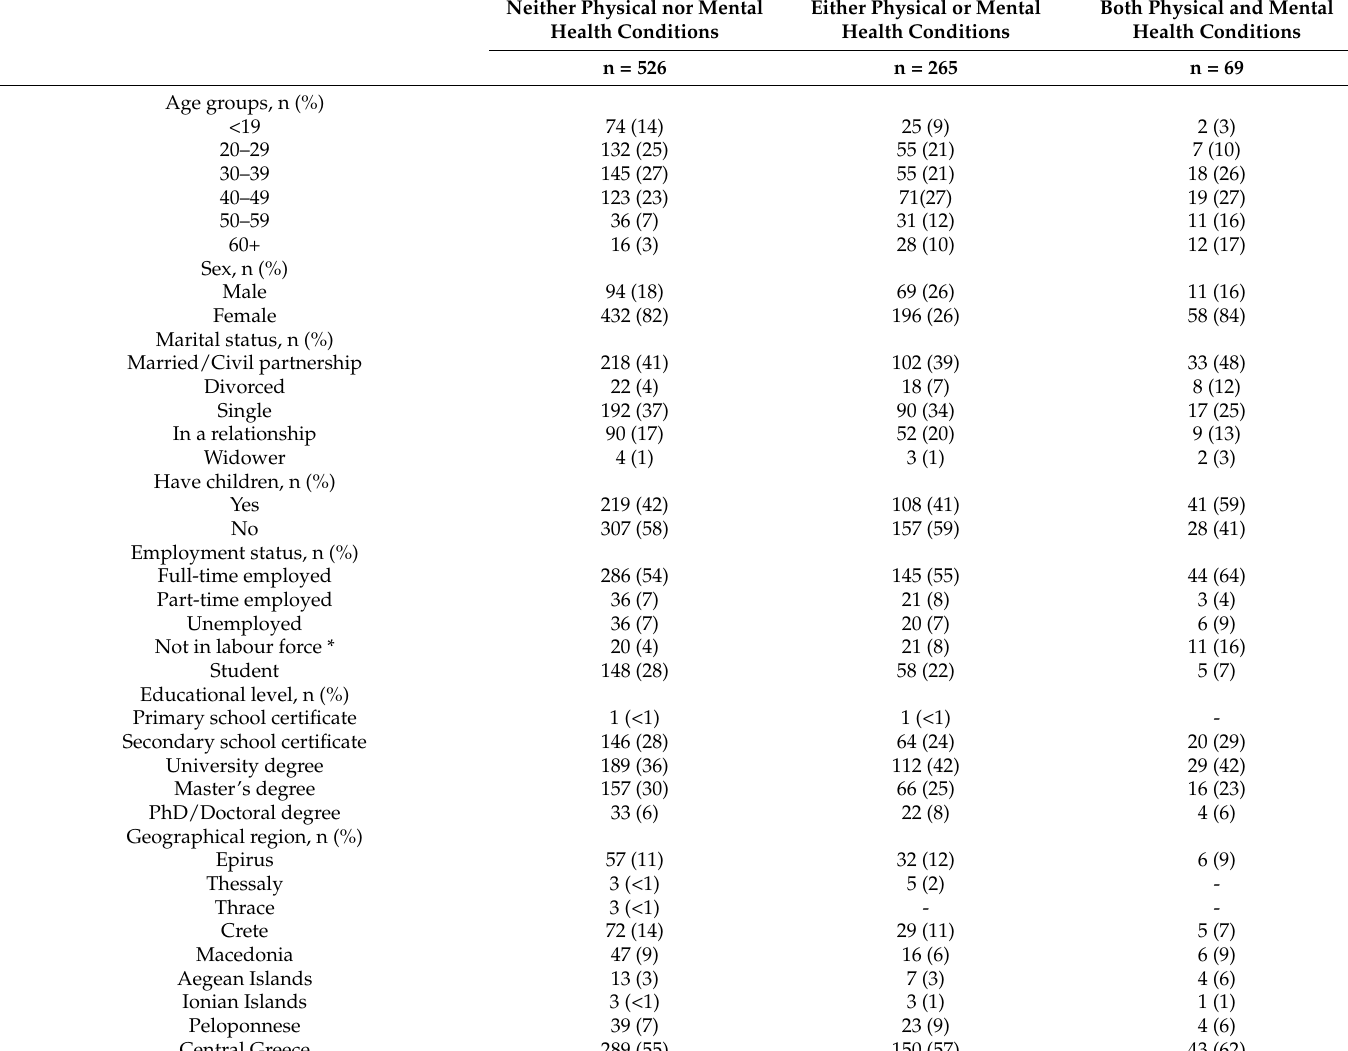
Table 1. Sociodemographic characteristics by health